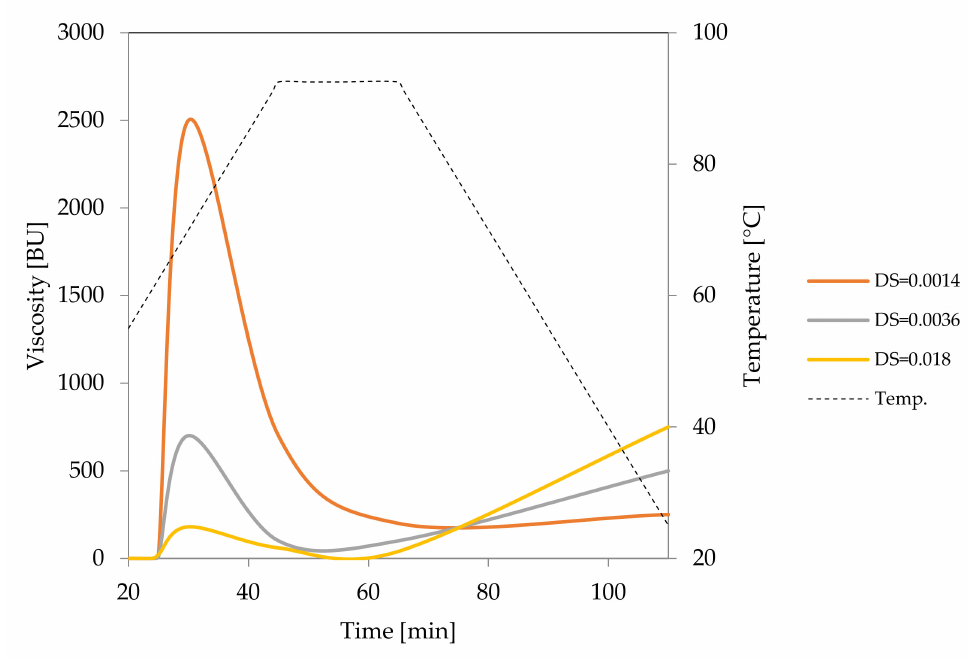
Figure 5. Pasting characteristics of oxidised starches recorded for starch dispersions in concentration of 8% (DS = 0.0014 and DS = 0.0036) or 20% (DS =